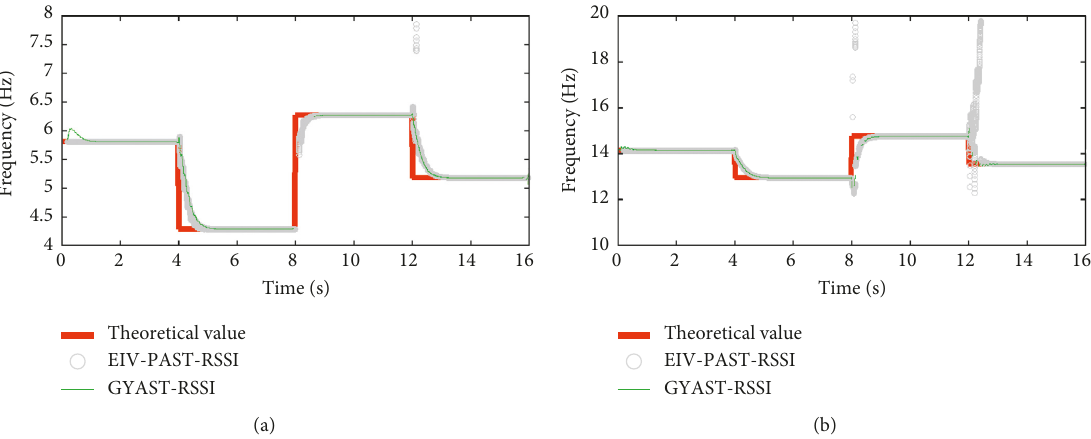
Figure 9: Frequency identification results of the first two modes using the different methods for simulation case 1 (SNR (b) mode